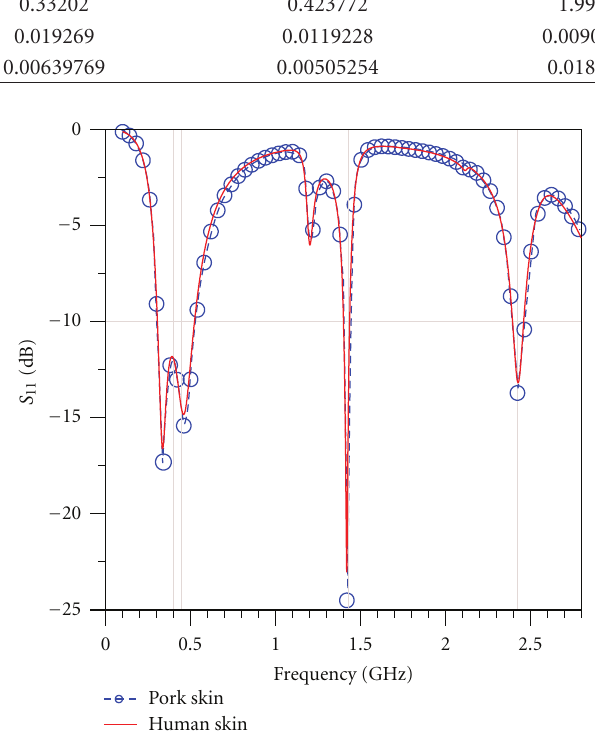
Figure 9: Simulated return loss of proposed antenna implanted into pork skin and skin.